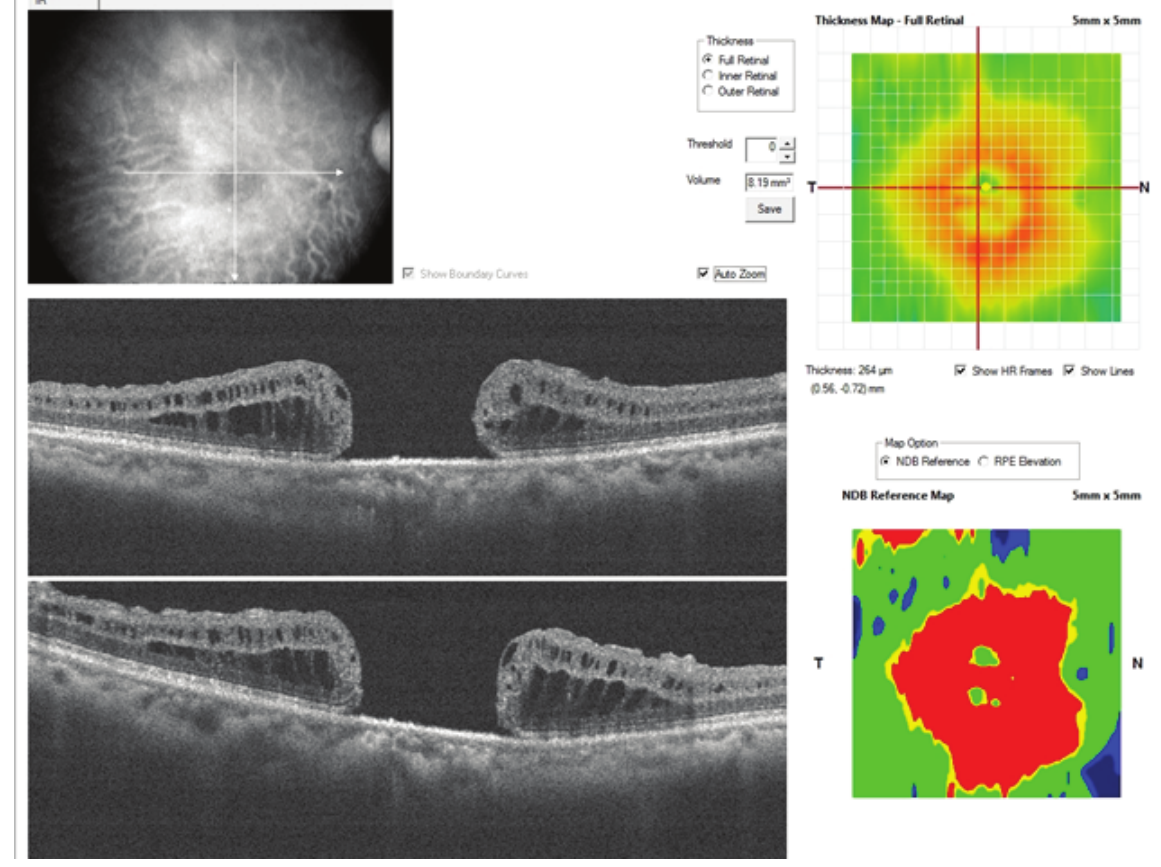
Figure 2. Patient 1; preoperative OCT cross-line horizontal and vertical scans of the macular